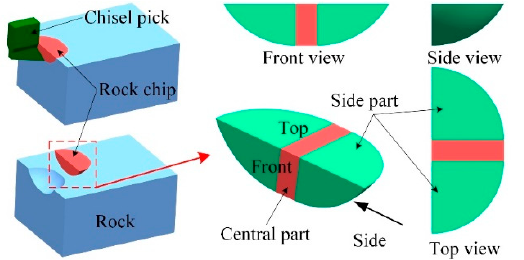
Figure 5. Idealized shape of the rock chip in the CEIT model.